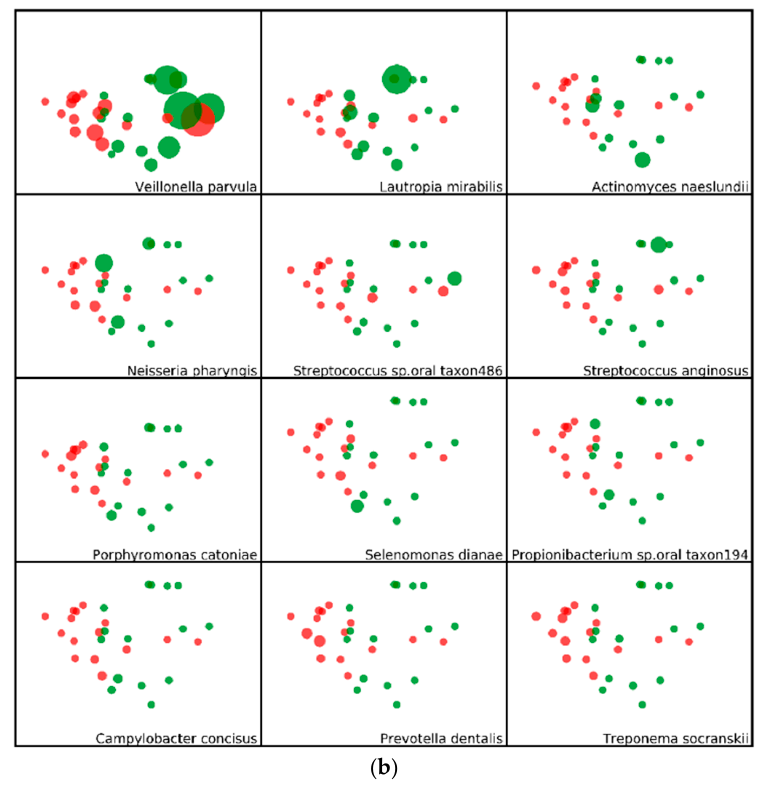
Figure 3. Beta-diversity analysis showing the top 12 bacterial species associated with periodontal disease and with no periodontal disease. The sizes of the datapoints are scaled to reflect the relative abundance of species in each sample. Red and green dots refer to women with and without periodontal disease, respectively. ( a ) Panel A. Bacterial species predominantly associated with periodontal disease; ( b ) Panel B. Bacterial species predominantly associated with no periodontal disease.